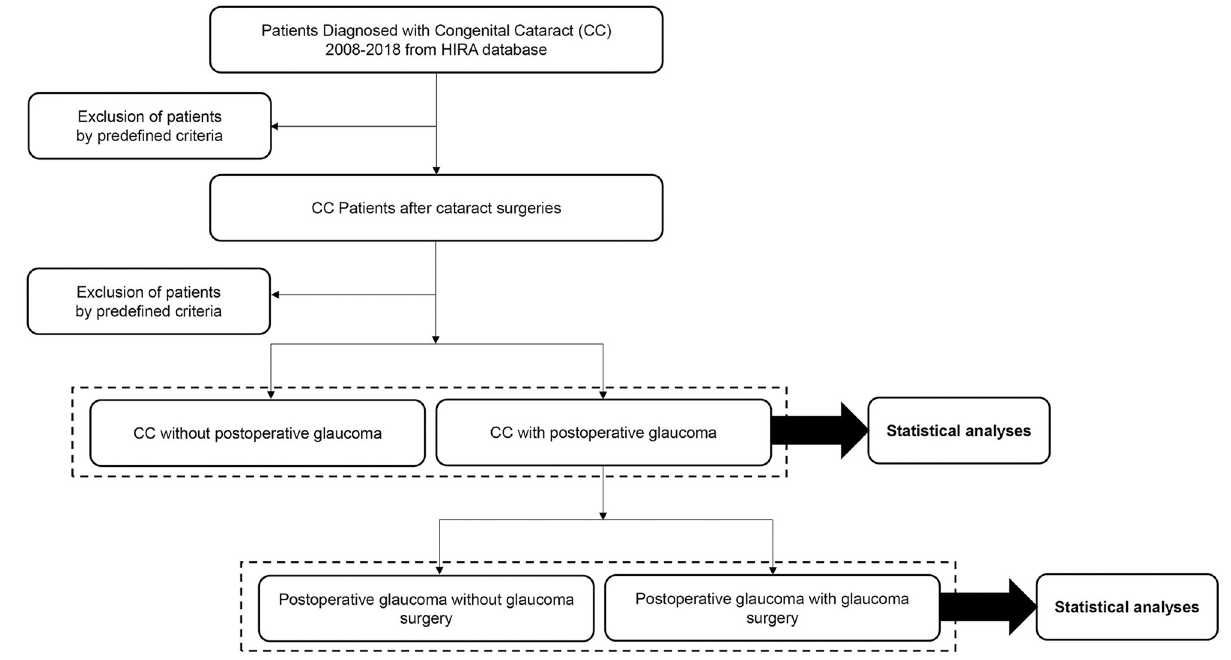
Fig 1. Flowchart of study